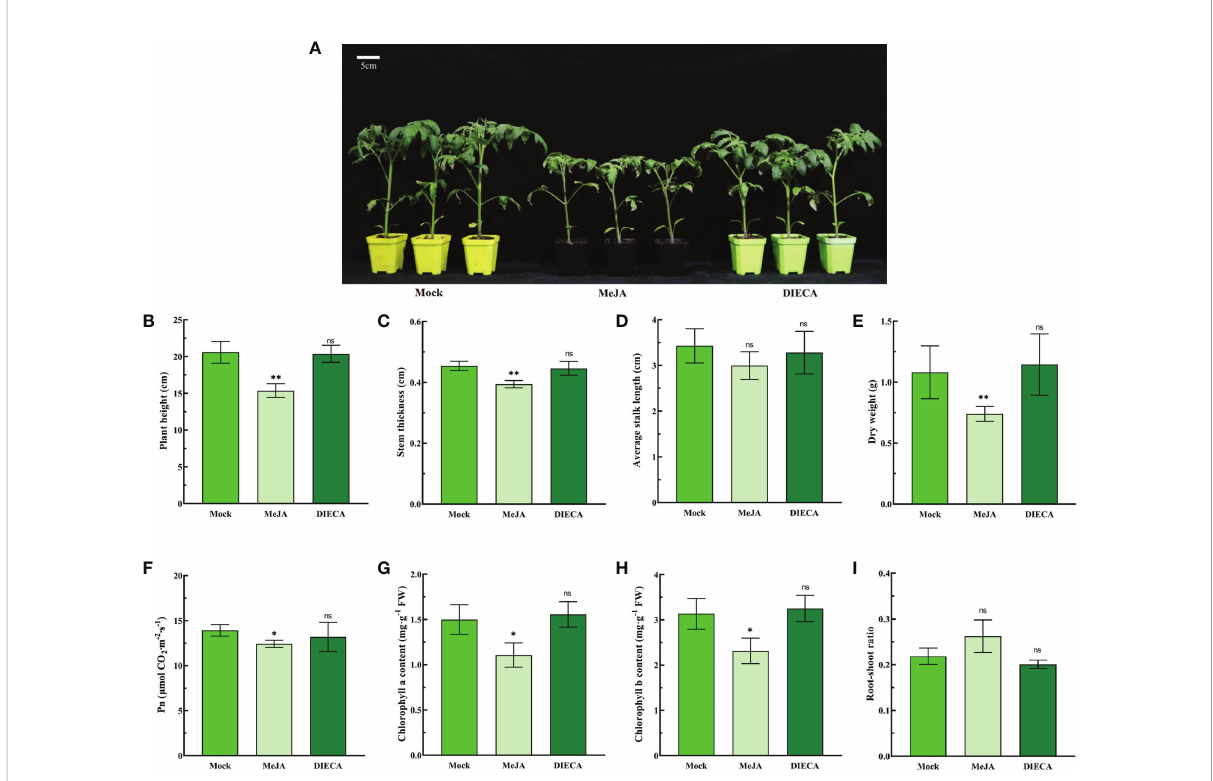
FIGURE 1 Effects of MeJA and DIECA on the growth and photosynthesis of tomato seedlings. (A) Phenotypic changes in 5-week-old seedlings after 1 week of treatment with 100 m M MeJA or 200 m M DIECA. (B) Plant height. (C) Stem thickness. (D) Average stalk length. (E) Dry weight. (F) Net photosynthetic rate (Pn). (G) Chlorophyll a content. (H) Chlorophyll b content. (I) Root – shoot ratio. Errors are standard deviations for three biological replicates (n=3). Differences between means were analyzed for signi fi cance using Student ’ s t test, *P < 0.05, **P < 0.01. ns, no signi fi cant